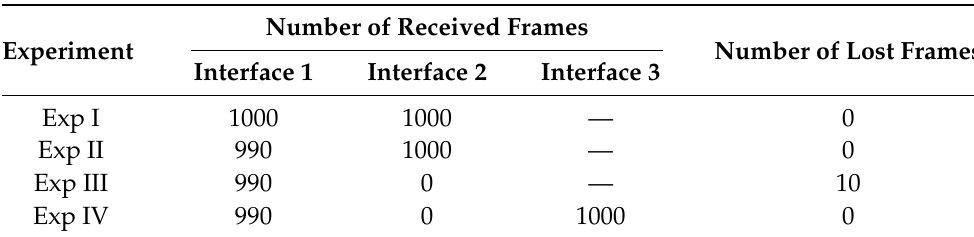
Table 1. Number of frames received through each port in the absence of faults, presence of temporary faults only and presence of temporary and permanent